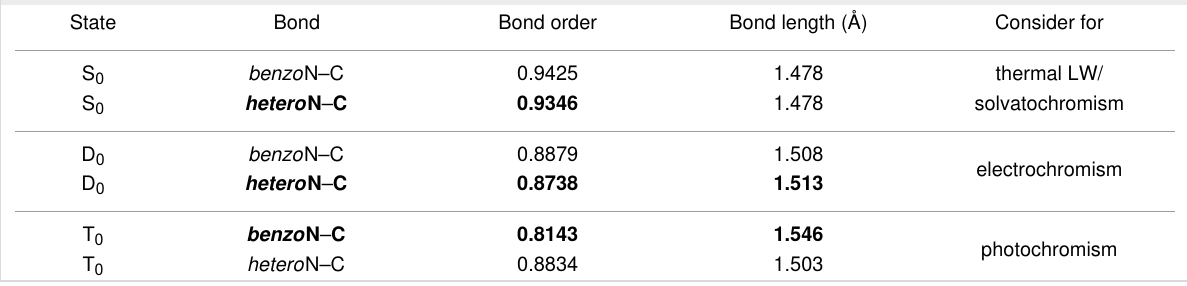
Table 2: Computed bond lengths and bond orders of the relevant N–C bonds for photochromic (T 0 ) and electrochromic (D 0 ) ring-opening of 3a . Bolded (longer and weaker) bond is the one that is cleaved in each case. State